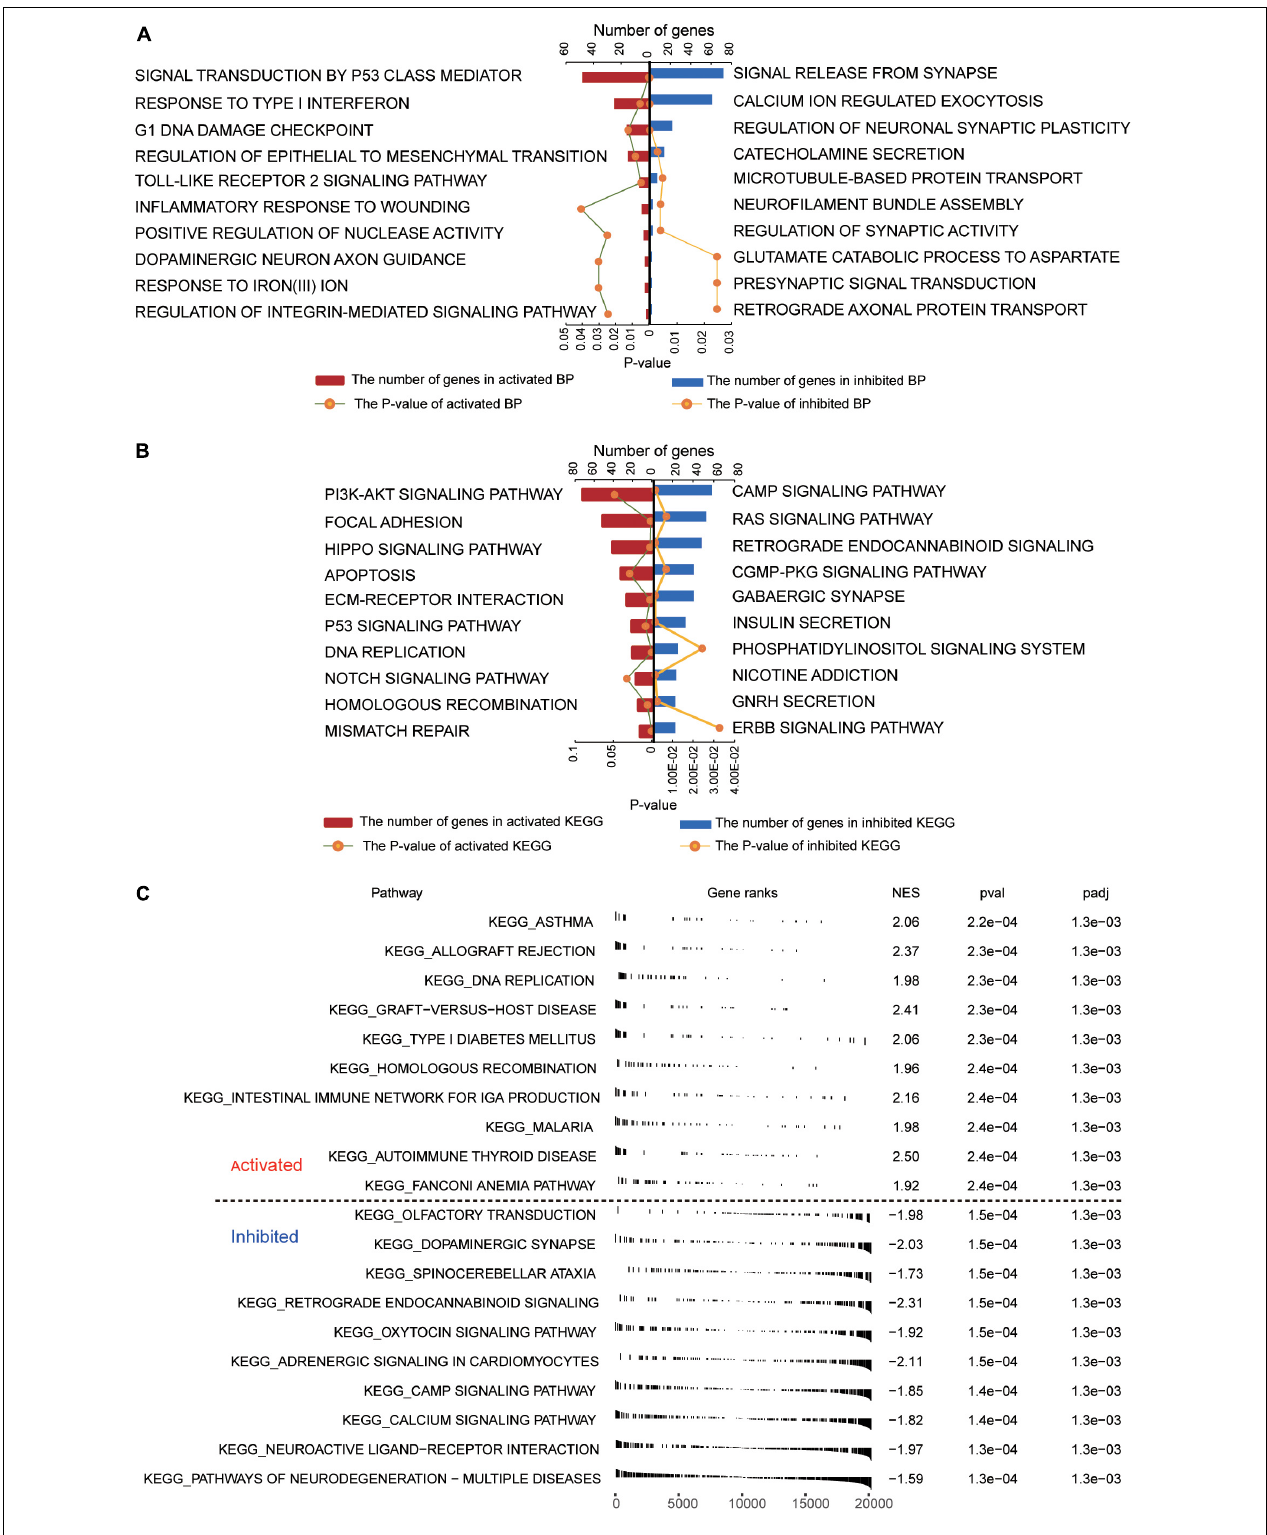
FIGURE 2 | Functional enrichment of common DEGs in GBM. (A) Biological processes activated (red) or inhibited (blue) by common DEGs in GBM patients relative to controls. (B) KEGG pathways activated (red) or inhibited (blue) by common DEGs in GBM patients relative to controls. (C) Activated or inhibited processes in GBM patients relative to controls, based on gene set enrichment